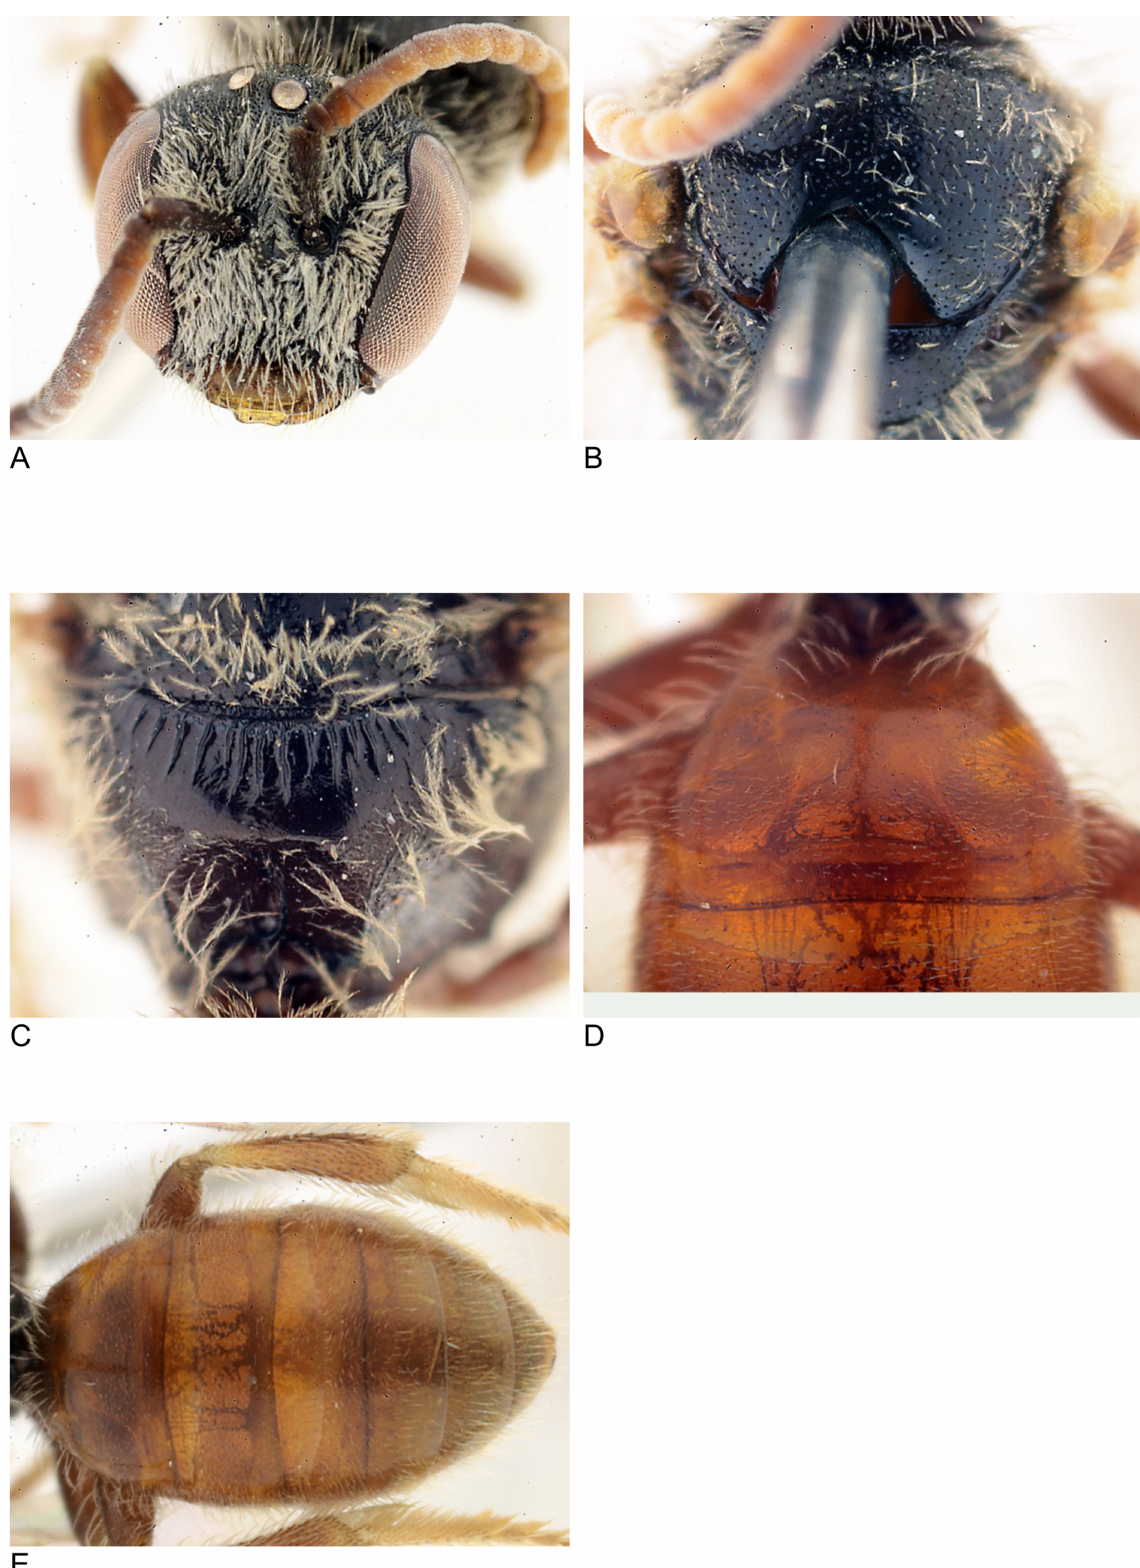
Fig. 14. Lasioglossum villosulum arabicum Ebmer, 2008, ♂ (UAE). A . Head. B . Scutum. C . Propodeum. D . First tergum. E .